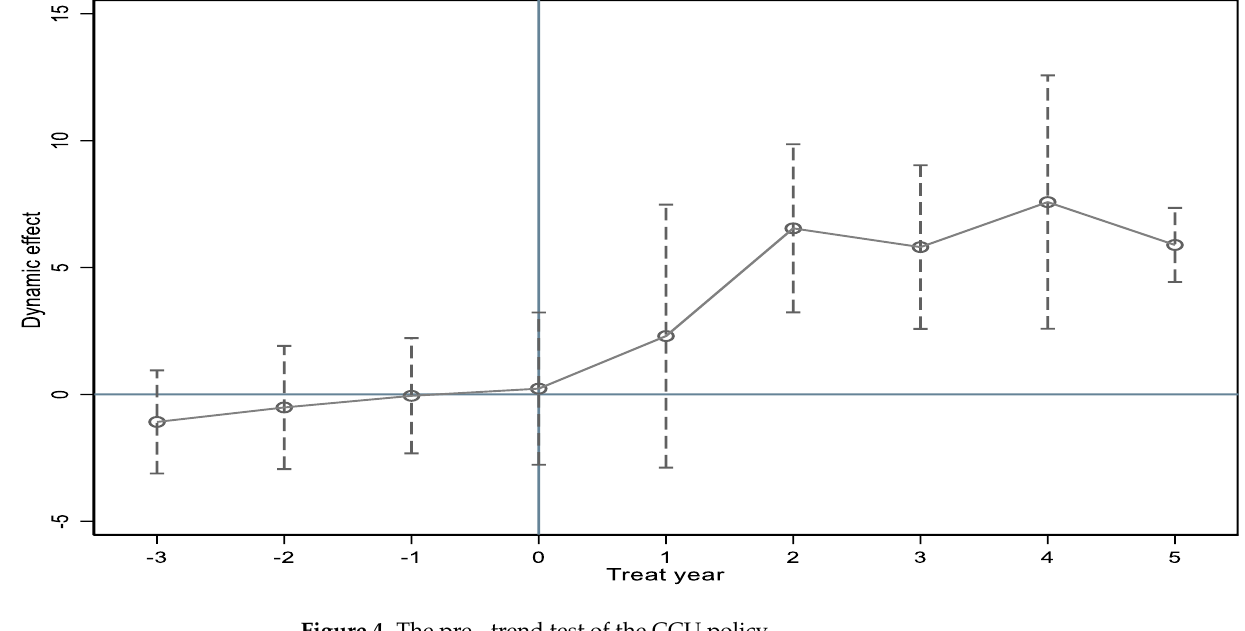
Table 3. The impact of the CCU policy on air pollution.